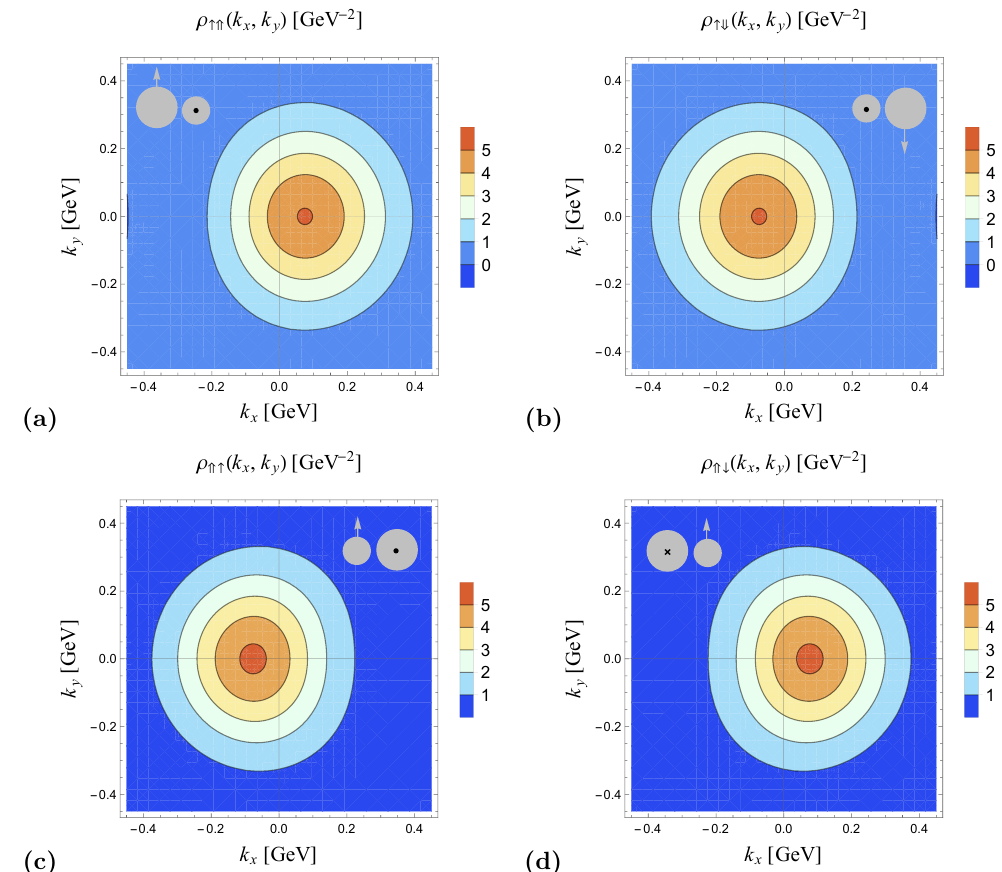
Figure 11 . (Color online) Quark density plots for ρ ↑⇑ ( k x , k y ) , ρ ↑⇓ ( k x , k y ) (upper panel) and ρ ⇑↑ ( k x , k y ) , ρ ⇑⇓ ( k x , k y ) (lower panel) in the momentum plane. The gray colored small and large circles (upper right or left corner) with dot and cross inside, denote the longitudinal polarization in same and opposite directions respectively. The arrow along upward and downward directions symbolize the transverse polarization of the quark and the ρ